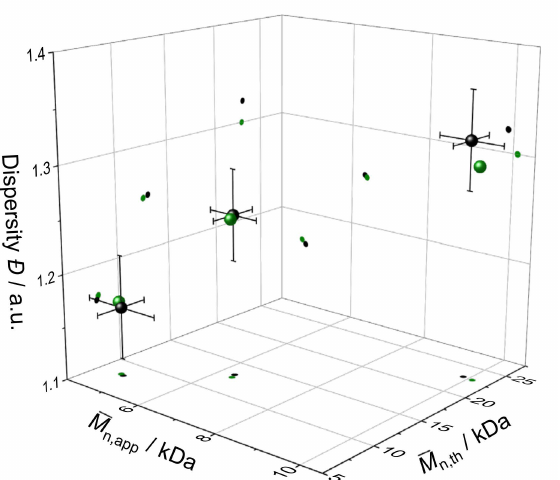
Figure 4. Predicted (black spheres) and observed (green spheres) responses of M n,th , Ð , and M n,app as well as the 95% PIs for the three arbitrarily picked polymerization goals. Value projection with respective coloring on the response planes is added as a guide to the